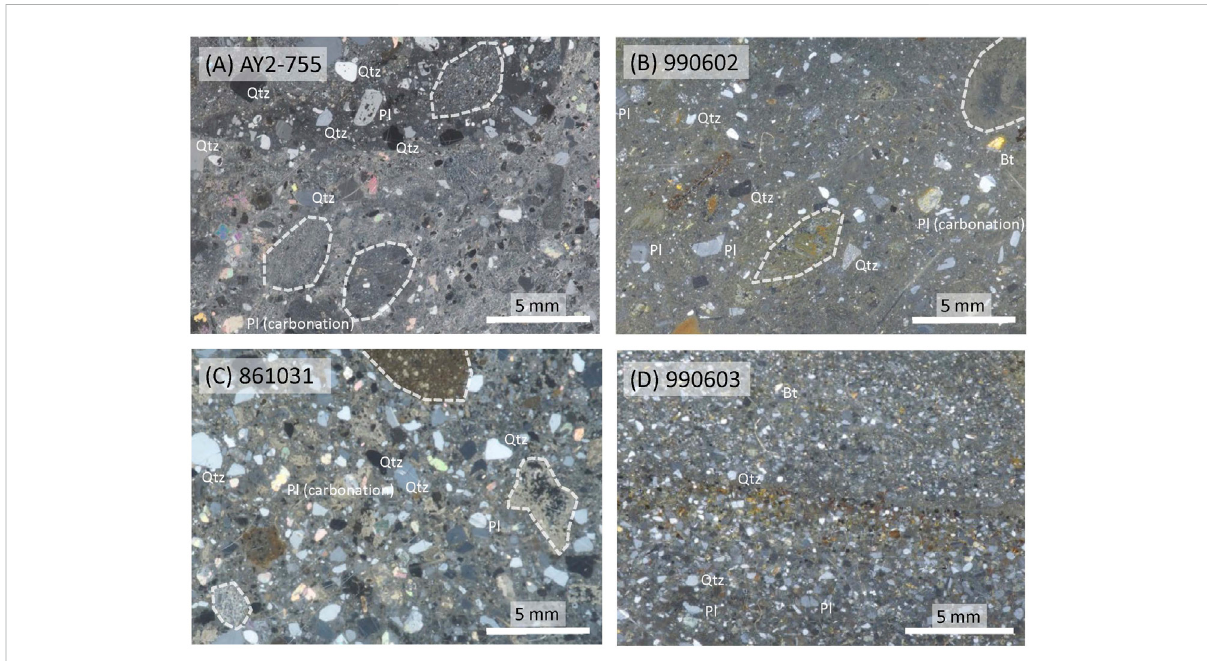
FIGURE 4 Thin section images ofrepresentative dated samples taken in cross-polarized light. (A – C) dacite lapilli tuff, (D) laminated sandy tuff. Some lithic fragments are encircled with dashed lines. Some plagioclases are partly altered to calcites. Abbreviations: Qtz, quartz; Pl, plagioclase; Bt,